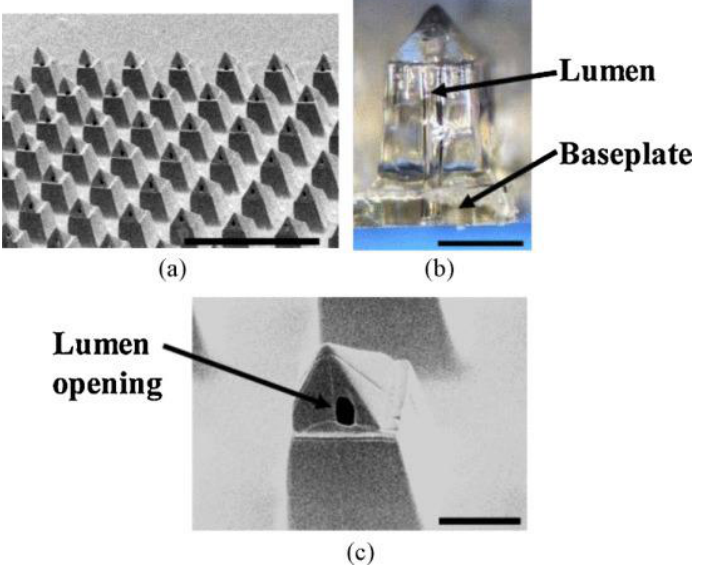
Figure 10. ( a ) An SEM image of bird’s-eye view of fabricated microneedle array coated by 15 nm Cr/150 nm Au for SEM imaging. ( b ) An optical micrograph showing a fabricated hollow microneedle with a baseplate. ( c ) An SEM image revealing the pyramidal tip with a lumen opening and upper shaft. The scale bar is 2 mm, 400 µ m, and 250 µ m in ( a – c ), respectively. © 2013 IEEE. Reprinted from Wang et al. [58] with permission.